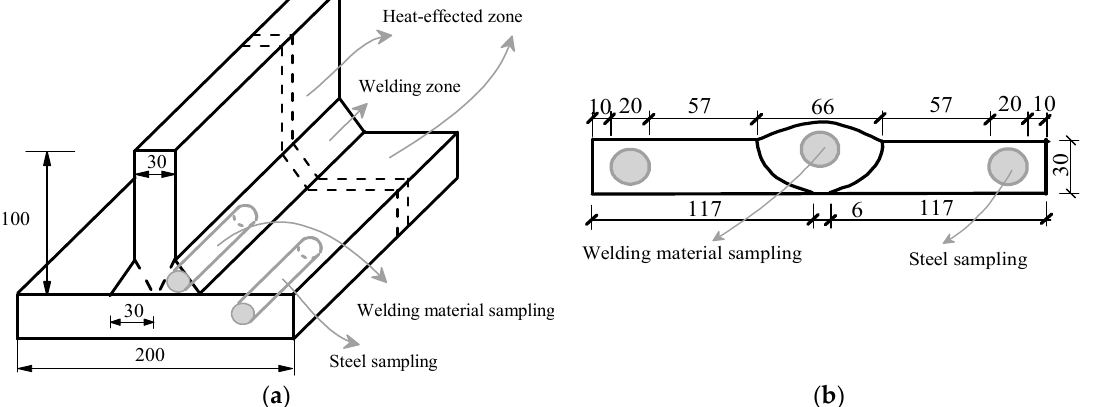
Figure 2. Acquisition of the standard specimen. ( a ) Sampling of fillet weld(mm); ( b ) Sampling of butt weld (mm).